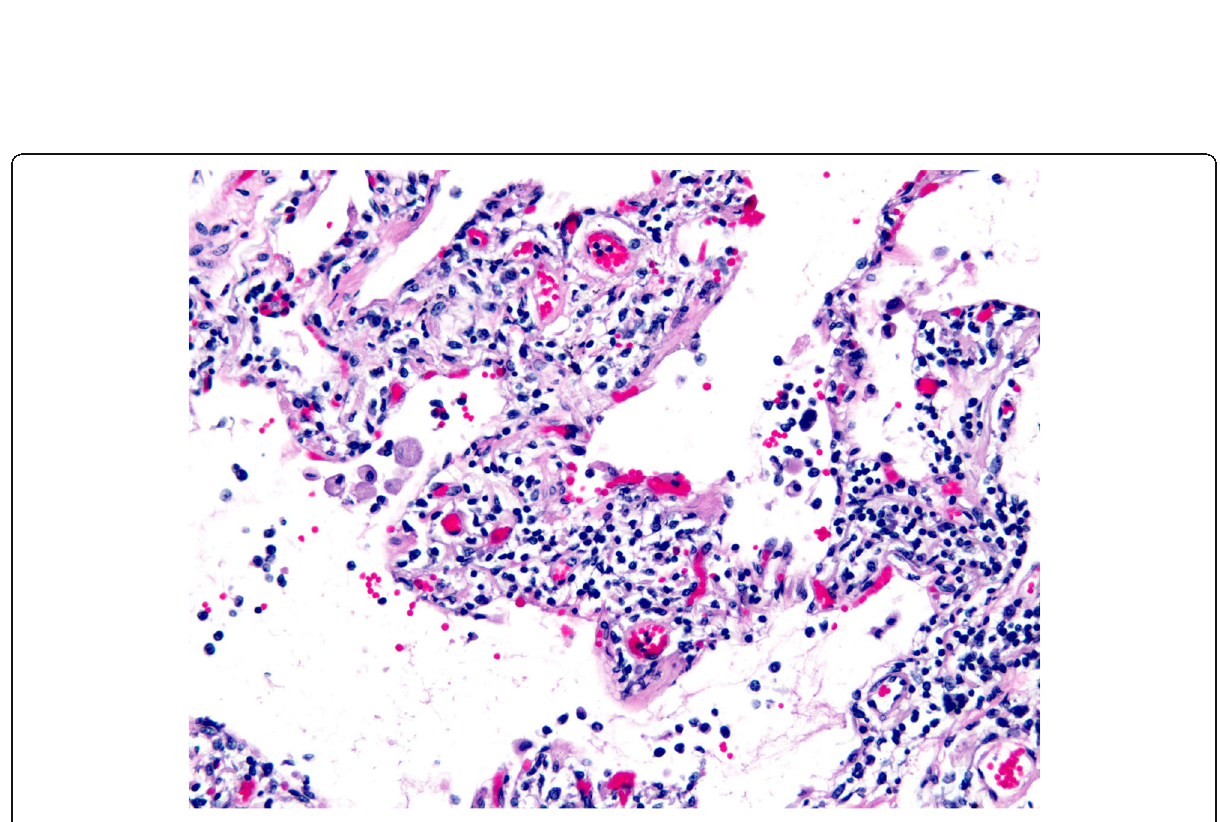
Fig. 6 Interstitial inflammation in COVID-19. The inflammatory cells are predominantly lymphocytes (Hematoxylin & eosin, original magnification ×